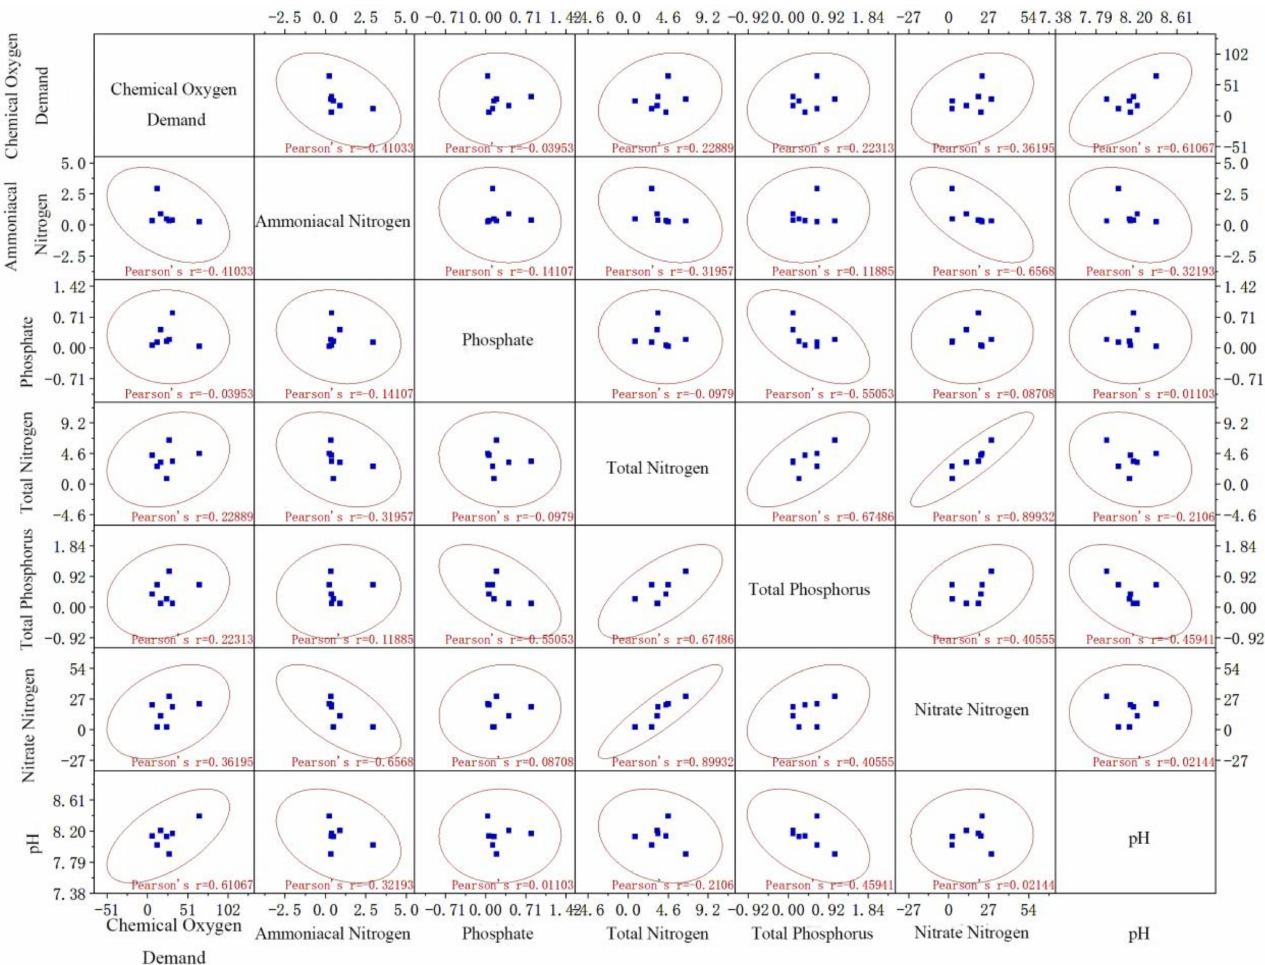
Figure 4. Correlation analysis of water quality indices using volcanic stone as the